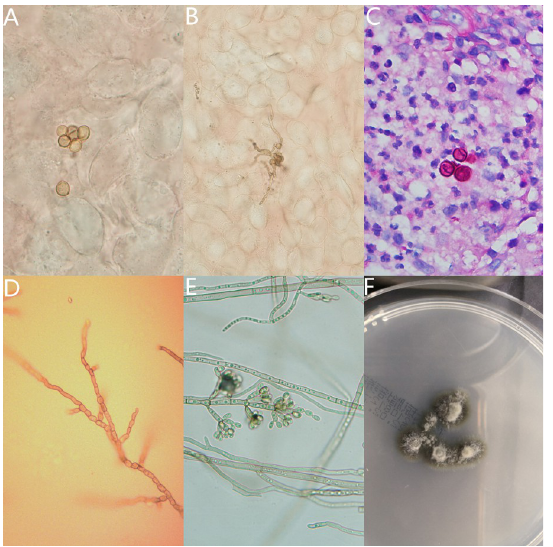
Fig 4. Mycological features of CBM. Pigmented muriform cell with obvious septation (A) and brown muriform cell with germinated hyphae (B) (10% KOH, × 400). Mixed granuloma with sclerotic body (PAS, × 400) (C). Slide culture on potato dextrose agar at 25˚C on day 8 of C . carrionii (D) and F . monophora (E) ( × 400). F . monophora colonies on SDA at 25˚C on day 7 (F).